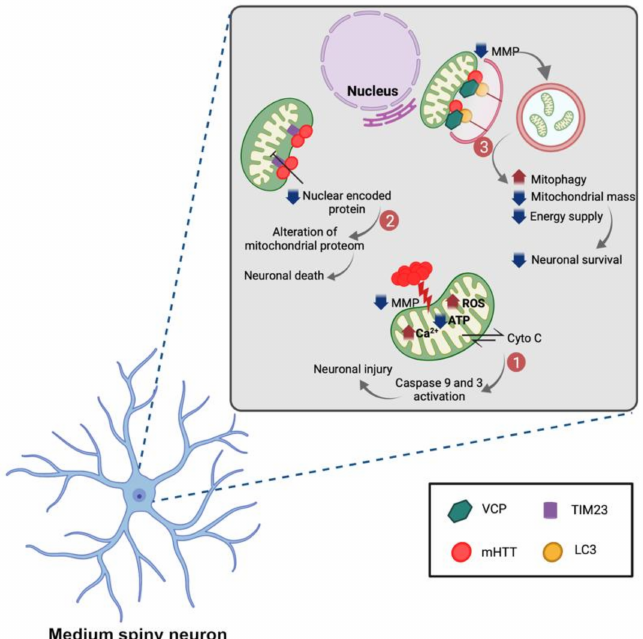
Figure 5. Mitochondria dysfunction associated with HD. mHTT aggregation disrupts the mitochon- drial membrane potential and increases excitotoxin-induced Ca2+ influx which leads to decreased ATP generation and increased ROS. Mitochondria dysfunction results in release of cytochrome C from the mitochondria which triggers the activation of apoptotic cascade via caspases 9 and 3, and neuronal injury. On the other hand, in HD, mHTT binds with high-affinity to TIM23 in mitochondrial intermembrane space, causing diminished levels of nuclear-encoded proteins imported through TIM23 and subsequently, neuronal death. Finally, VCP is selectively translocated to the mitochon- dria, where it is bound to mHTT and LC3 to enhance mitophagosome production, and reduce mitochondrial mass and energy supply, causing neuronal cell death. Created with